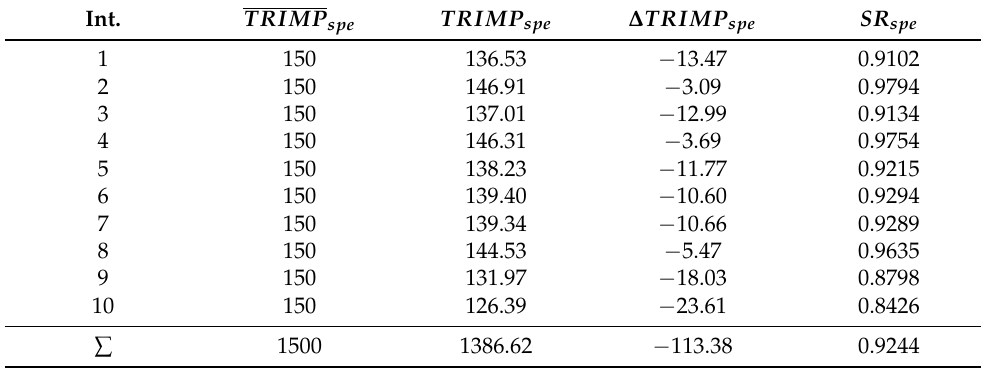
Table 3. Professional cyclist results by interval speed intervals.